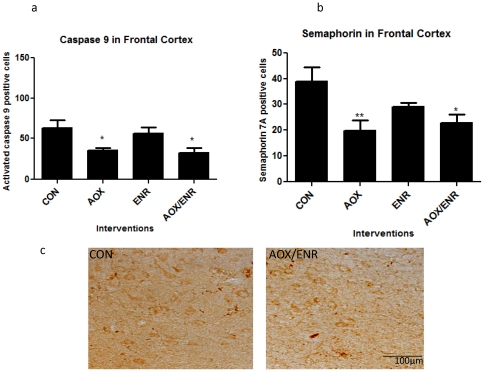
Interventions reduce activation of caspase 9 and semaphorin 7a expression in aged canine brains.
a) Active caspase 9 immunohistochemical staining in frontal cortices of aged dogs treated with AOX and/or ENR interventions showed significant reduction in expression of active caspase 9 in the AOX and combined treatment groups *p<0.05. b) Expression of semaphorin 7a, was reduced in frontal cortices of aged dogs in the AOX (**p<0.01) and AOX/ENR (p<0.05) groups. c) Representative images of semaphorin 7a staining in frontal cortices of CON and AOX/ENR groups.